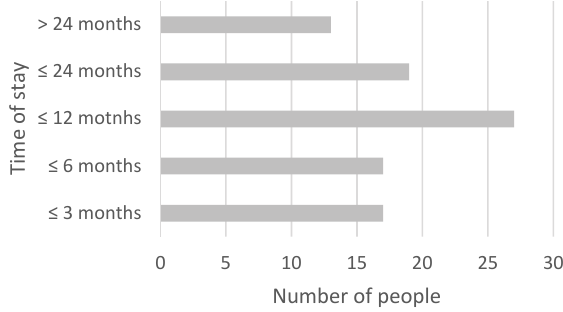
Figure A16. Time of stay in Simonsland, second survey (93 individuals).